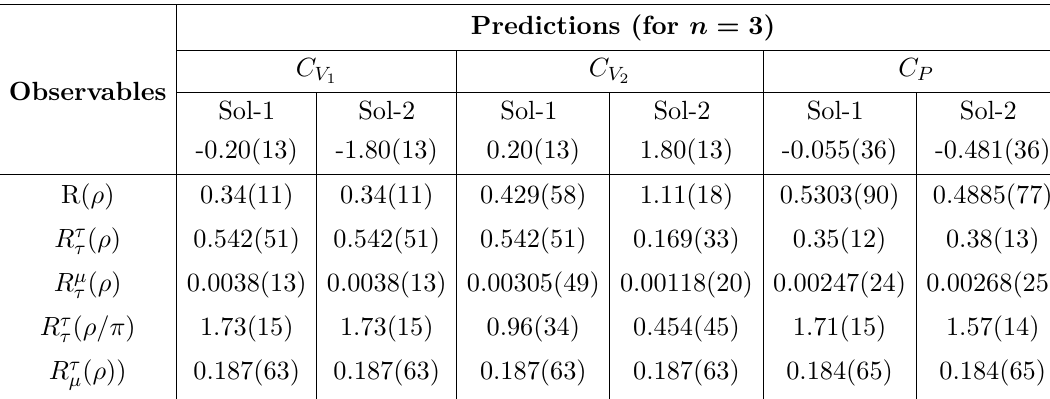
Table 7. The results of the observables defined in eqs. (2.10) and (3.4) corresponding to the two NP solutions obtained from fitting to dataset defined in ‘Fit-3’ with NP in B → τν .